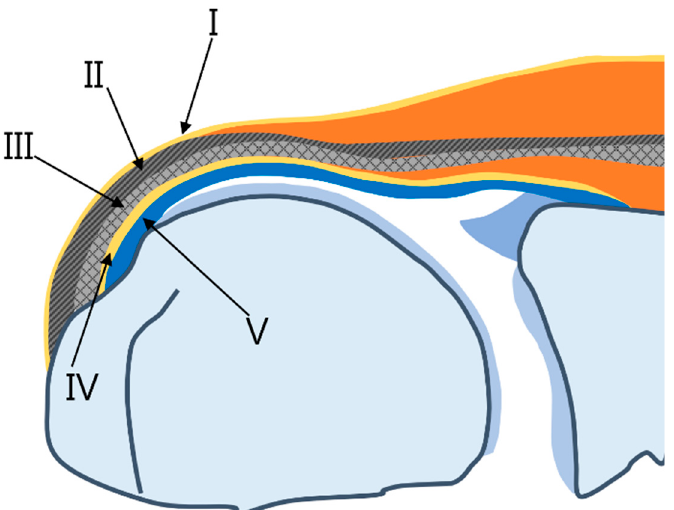
Figure 1. Schematic diagram of supraspinatus insertion with the histologic layers of the cuff in the coronal plane. Layer I is the most superficial layer, measuring 1 mm in thickness and composed of fibers from the coracohumeral ligament which overlay the cuff tendons. Layer II is composed of densely packed fibers that parallel the long axis of the tendon. Layer III is a deep tendon layer composed of smaller fascicles compared to layer II which are organized at an approximately 45 degree angle to the long axis of the tendon. Layer IV comprises loose connective tissue and thick collagen bands perpendicular to tendon fibers and merges with the coracohumeral ligament. Layer V represents the shoulder capsule.